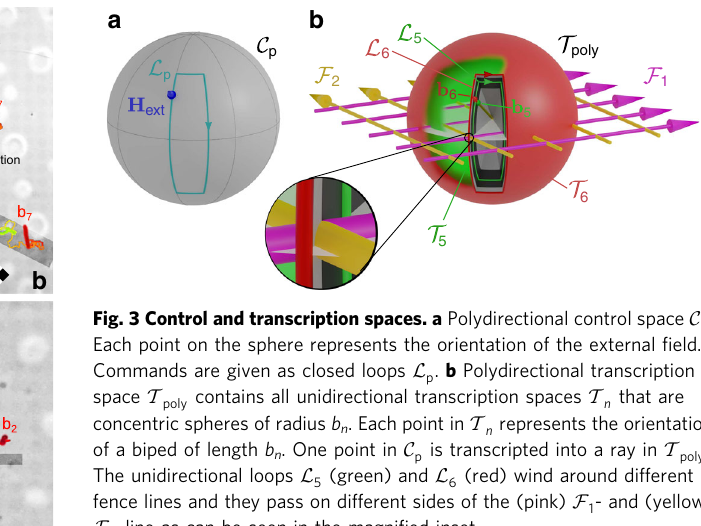
same trajectory (letter T). As we show below the reason is that b 2 < b 3 < a with a ≈ 11 μ m the lattice constant of the pattern. Both b 2 and b 3 bipeds respond in the same way to the parallel polydirectional loop despite being at different locations. The parallel polydirectional loop does not address the location of the bipeds but only their shape.